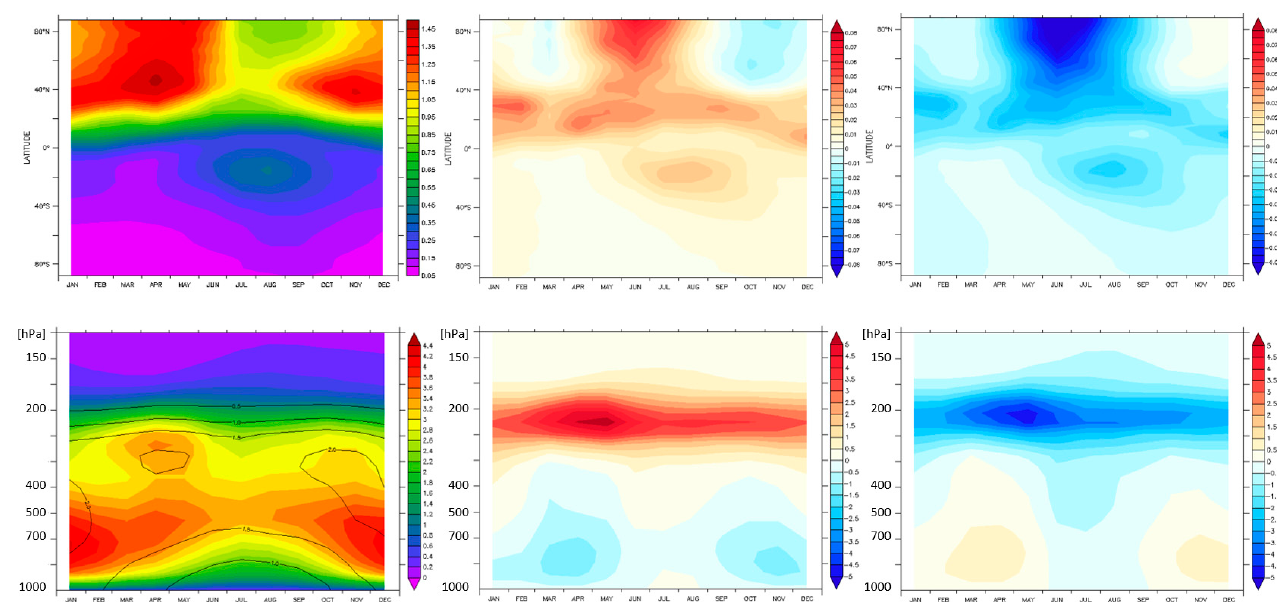
Figure 4. Aviation-induced ozone and changes when aircraft flying at alternative altitudes: Hovmöller diagram (upper row) of aviation-induced ozone (columns in DU), showing seasonal change (Jan-Dec, x-axis) over latitudes (y-axis) and seasonal change of vertical partial columns (lower row) for Jan-Dec (x-axis) of aviation-induced partial ozone columns (in 0.01 DU) over different altitudes (y-axis): aviation signal comparing reference case with no aviation scenario (perturbation, left ), and changes in partial columns (in 0.001 DU) for alternative flight altitude inventories with Flying Higher ( middle ) and Flying Lower ( right